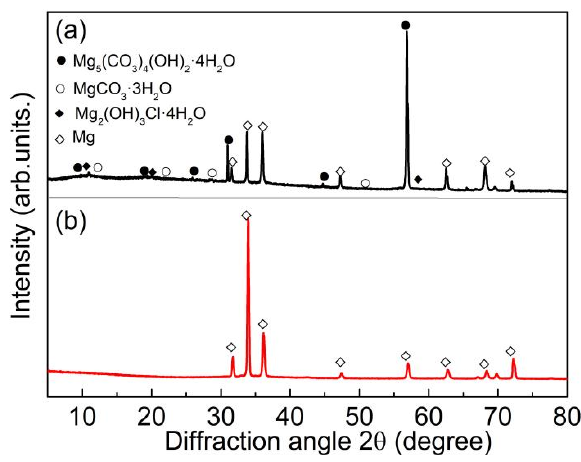
Figure 10. XRD patterns of AZ31 magnesium alloy: ( a ) corrosion products, ( b ) matrix.